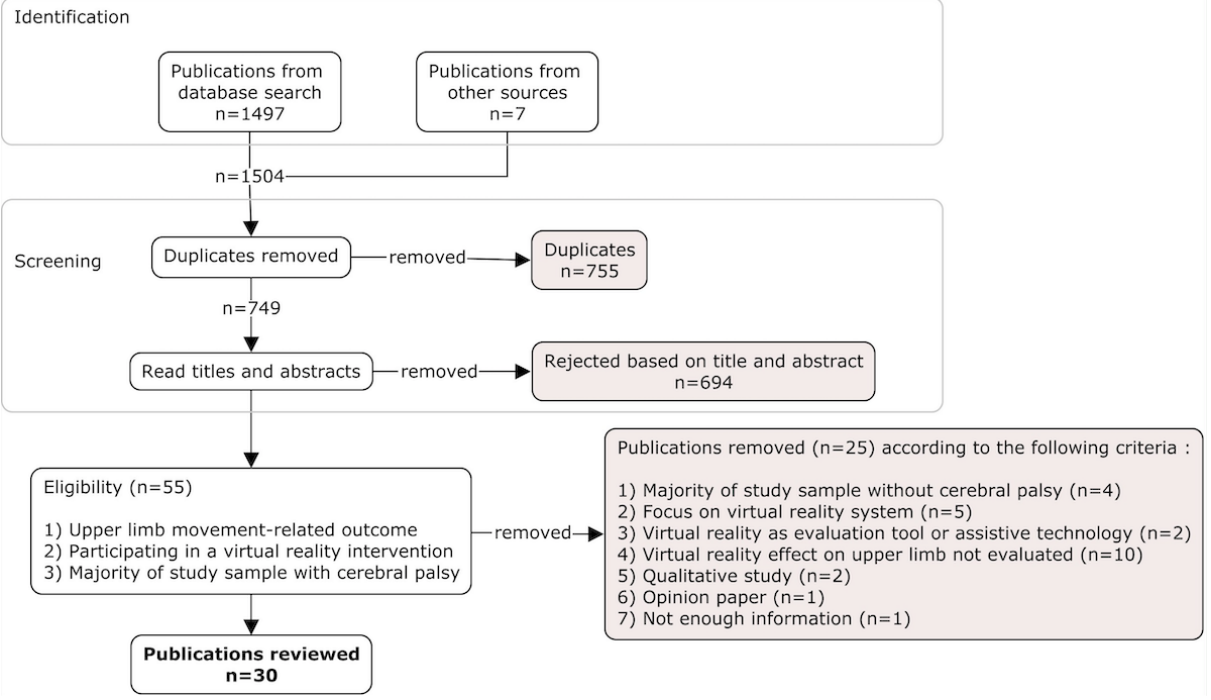
Table 1. Quality assessment of the reviewed studies based on the 27-item modified version [39] of the Downs and Black checklist [40].